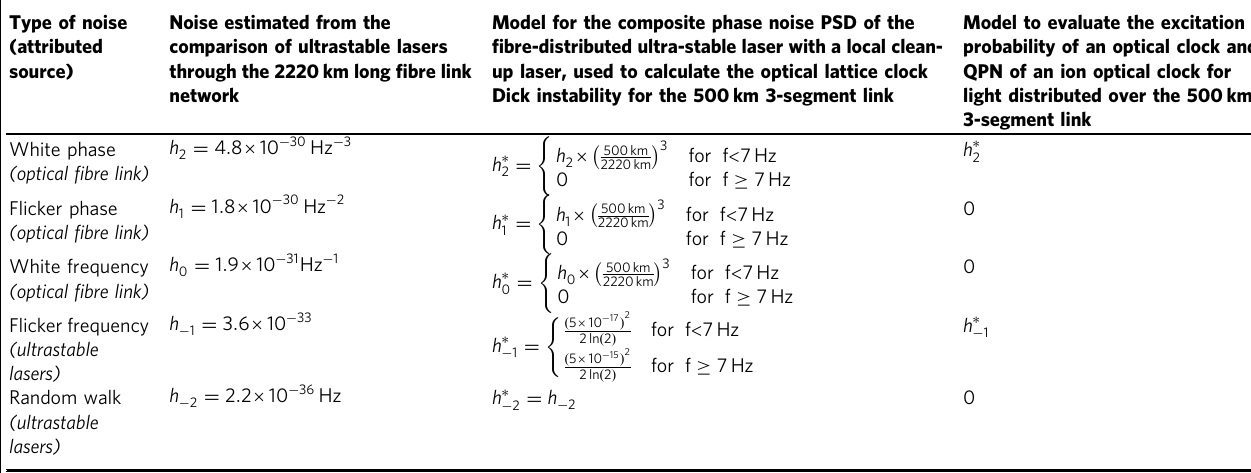
Model for the composite phase noise PSD of the fi bre-distributed ultra-stable laser with a local clean- up laser, used to calculate the optical lattice clock Dick instability for the 500 km 3-segment link